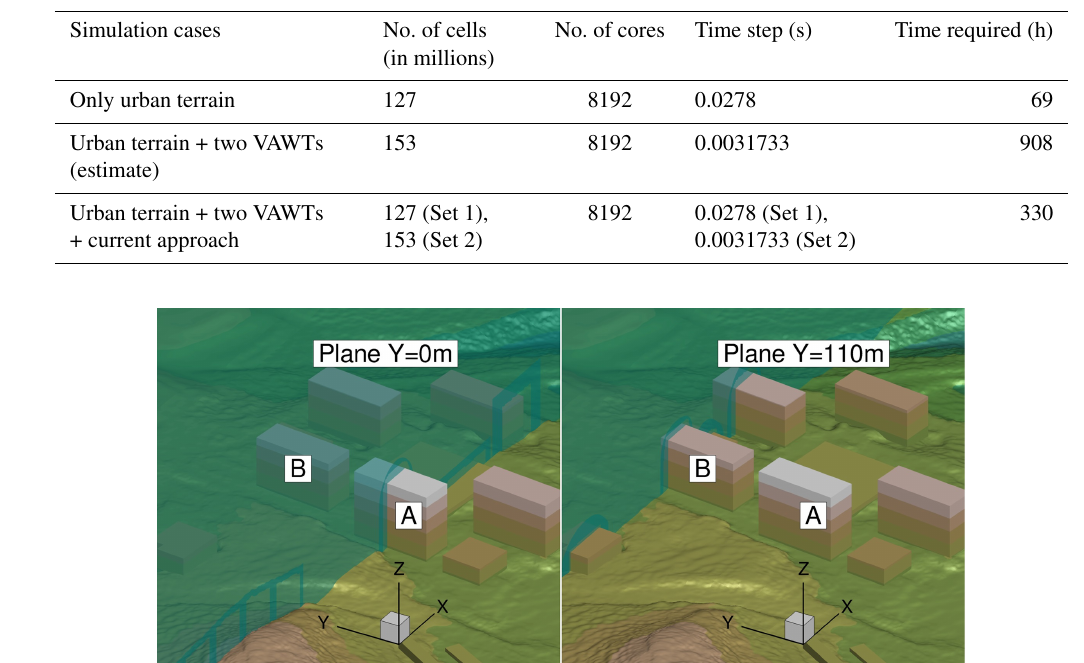
for the different tip speed ratios during the last